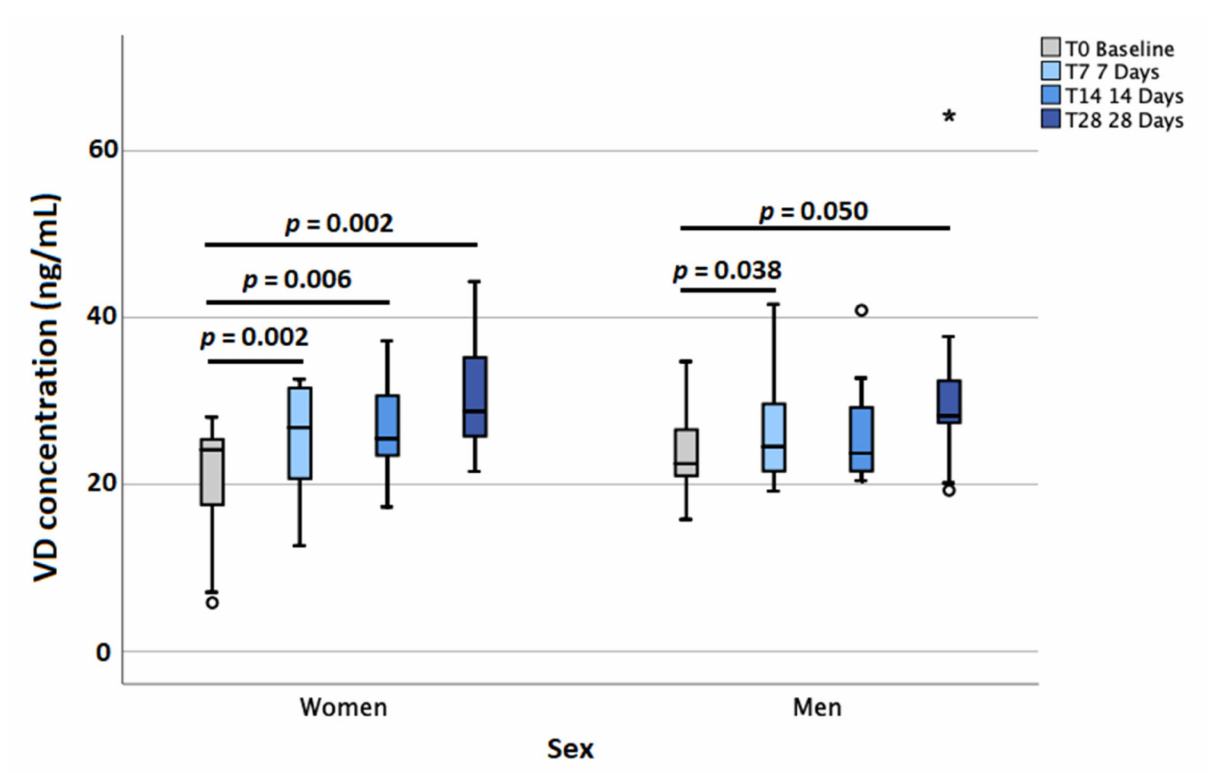
Figure 2. Plasma vitamin D (VD) concentrations measured at baseline and at 7, 14, and 28 days after the beginning of supplementation.